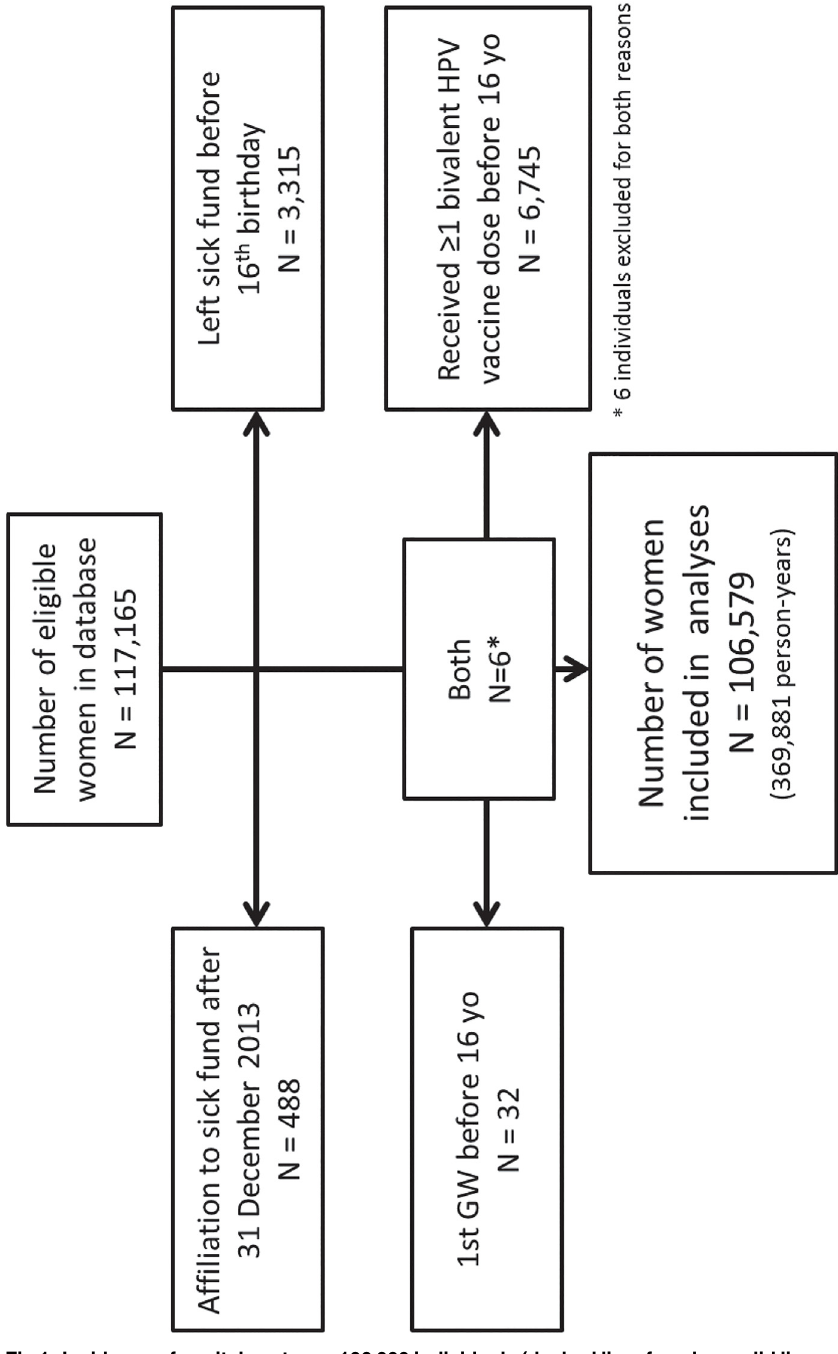
Fig 1. Incidence of genital warts per 100 000 individuals (dashed line: females; solid line: males) and qHPV vaccine uptake in individuals aged 16 – 22 years (A), 23 – 30 years (B), 31 – 40 years (C) and 41 – 59 years (D) affiliated to the MLOZ sick fund (Belgium) between 2006 and 2013 (standardised estimates).